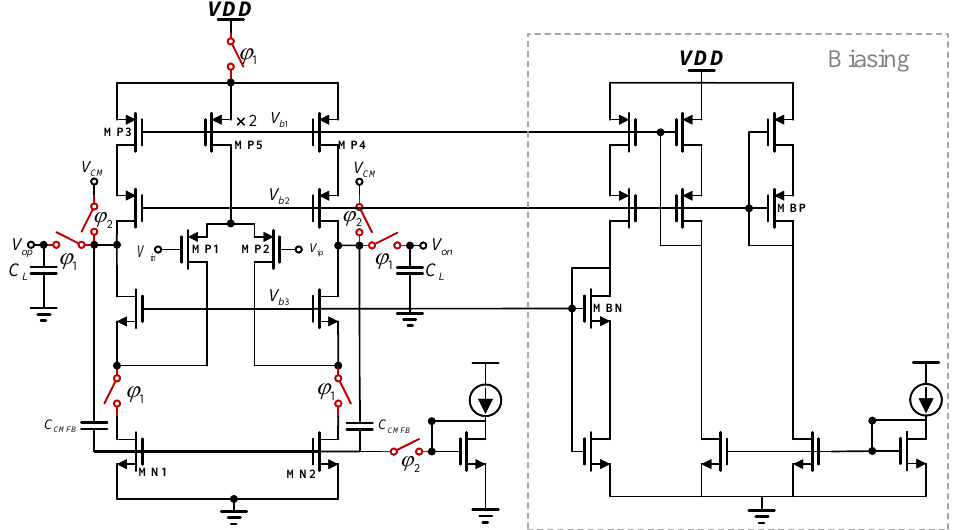
Figure 7. Schematic of a dynamic amplifier with bias